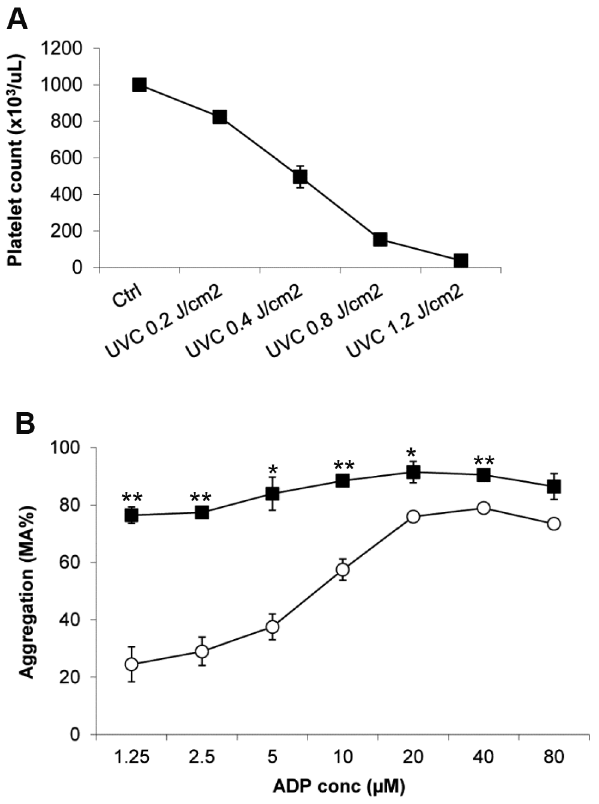
Figure 1. UVC irradiation induced platelet aggregation and potentiated ADP induced platelet aggregation. A ) Human platelets (HPs) at 1 x 10 6 /µL were exposed to 0.2 (30 seconds), 0.4 (1 minutes), 0.8 (2 minutes), and 1.2 J/cm 2 (3 minutes) UVC illumination. Single platelet count was measured immediately after light exposure on a Cell-Dyn 3700 blood cell counter. Mean ± SE, n=8. B ) in vitro aggregation assay was performed with untreated (Ctrl, open circle) or UVC-exposed platelets (0.2 J/cm 2 , filled square). Y axis represents percent of maximal aggregation (%MA). Mean ± SE,